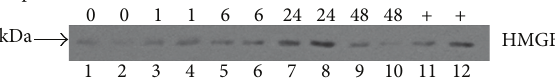
Figure 2: Time course of plasma HMGB1 level after pseudofracture (PF). Western blot of HMGB1 in plasma at time points after PF. LPS- stimulated macrophages were used as positive controls (lanes 11-12). Control mouse was used as time 0. 𝑛 = 3 mice per time